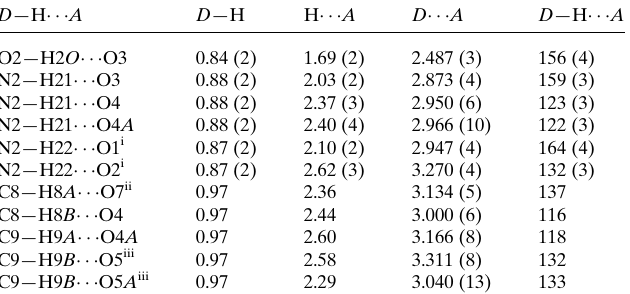
Table 8 Hydrogen-bond geometry (A˚ , (cid:5) ) for 9 .